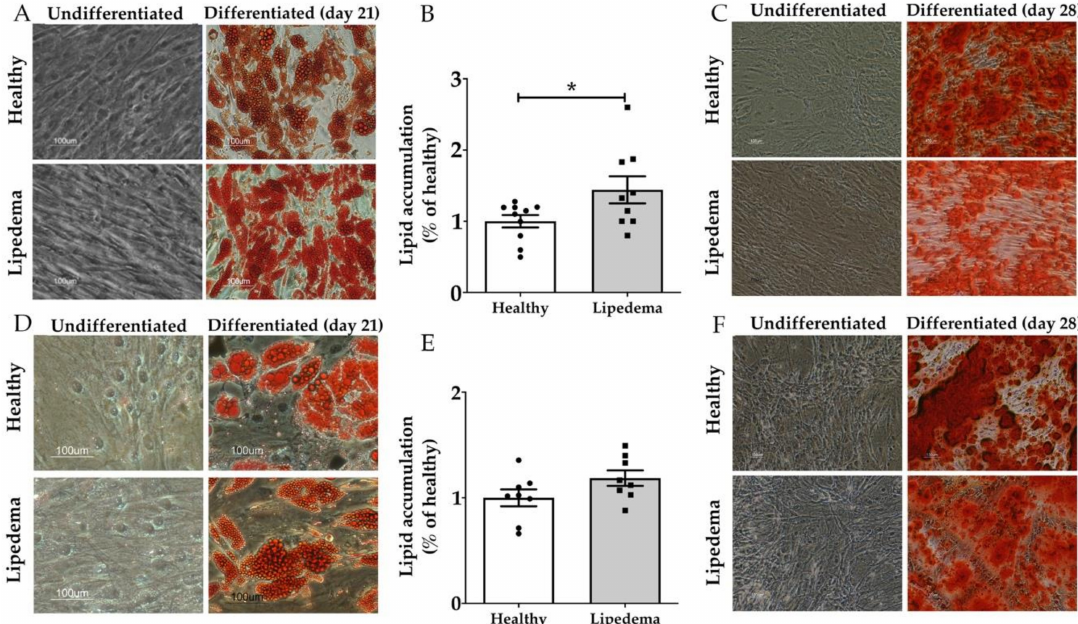
Figure 2. The in vitro adipogenic and osteogenic di ff erentiation potential of ( A – C ) ASCs-T and ( D – F ) ASCs-A. ( A , D ) Representative photomicrographs of the adipogenic di ff erentiation of ASCs determined by Oil Red O staining three weeks after the adipogenic induction. Lipid droplets (red) observed inside di ff erentiated cells. No stain in the undi ff erentiated cells (scale bar, 100 µ m). ( B , E ) The quantitative analysis of Oil Red O stain by spectrophotometric analysis showing a significant increase in the adipogenic di ff erentiation potential of lipedema ASCs-T compared to healthy ASCs-T (ASCs-T: healthy n = 10 and lipedema n = 9, ASCs-A: n = 8 per group). The results are displayed as scatter plots with bars. The values are the mean ± SEM. * p < 0.05. ( C , F ) Representative photomicrographs of the osteogenic di ff erentiation of ASCs determined by alizarin red staining four weeks after osteogenic induction (scale bar, 100 µ